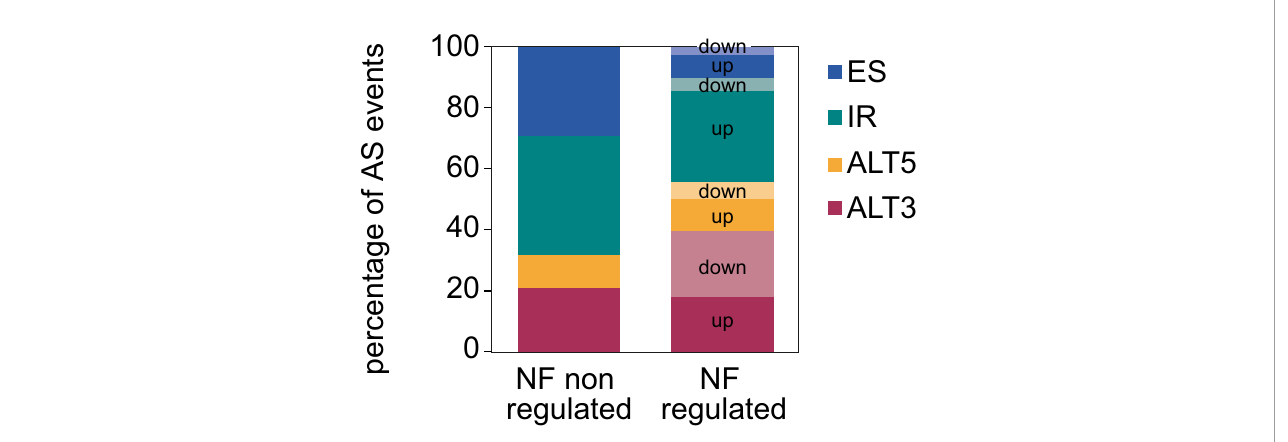
FIGURE 2 Distribution of the different types of AS events regulated by nor fl urazon. Number of each type of AS events for which inclusion is differentially up- or downregulated by nor fl urazon (NF). NF non-regulated AS events represent the proportion of the different types of AS events in the genome (see Material and Methods for details). ALT5, alternative 5´splice site; ALT3, alternative 3´splice site; IR, intron retention; ES, exon